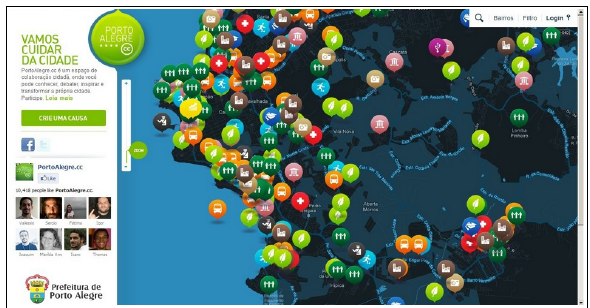
Figure 3. Interface of collaborative project